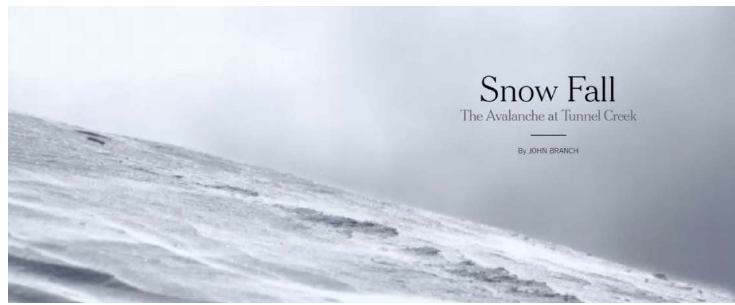
Figure 1. “Title page” of Snow Fall .